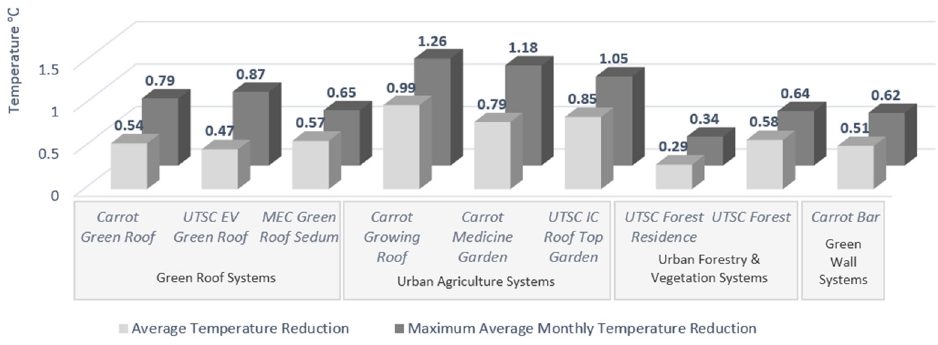
Figure 3. Average temperature reduction in grey and maximum average monthly temperature re- duction in black by green infrastructure application for each site from July to August 2016 and July to August 2017 [37]